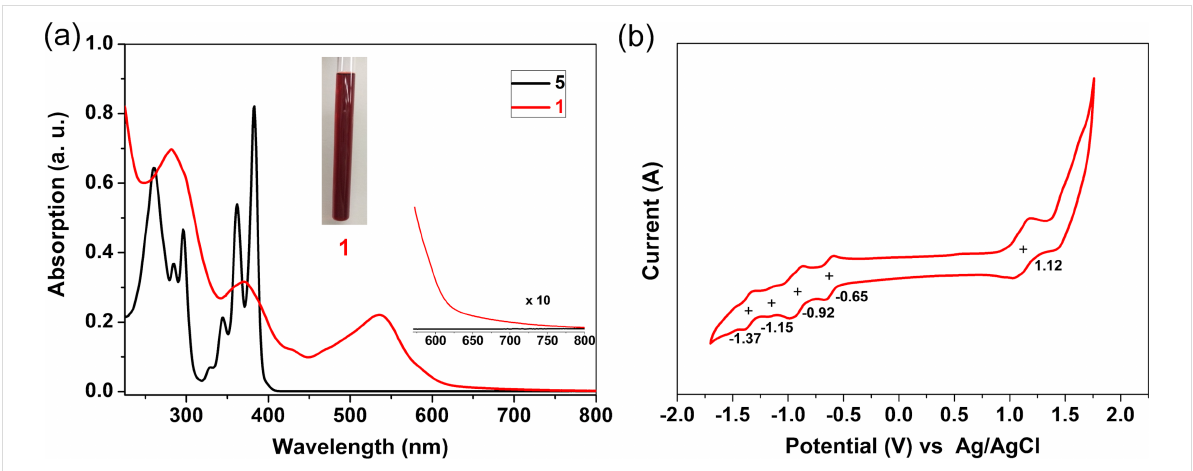
Figure 3: (a) UV–vis absorption spectra of precursor 5 and 1 in CH 2 Cl 2 solution (10 − 5 M). Inset: photograph of a CH 2 Cl 2 solution of 1 . (b) Cyclic voltammogram of 1 (0.1 M n -Bu 4 NPF 6 in DCM) at a scan rate of 50 mV s − 1 .